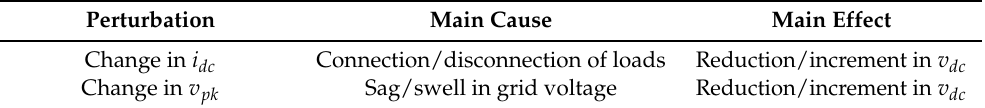
Table 1. PFC main perturbations, causes and